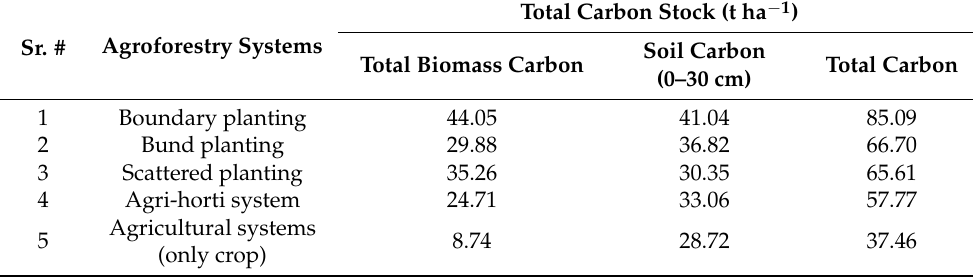
Table 6. Total Biomass + Soil (ecosystem) carbon stock of different agroforestry systems under the semi-arid